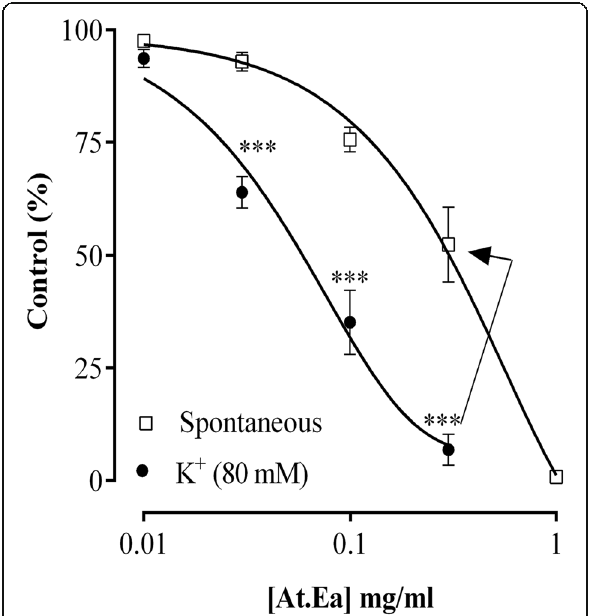
Fig. 6 Effects of Asphodelus tenuifolius ethylacetate fraction (At.Ea) upon spontaneous contractions and K + (80mM) induced contractions